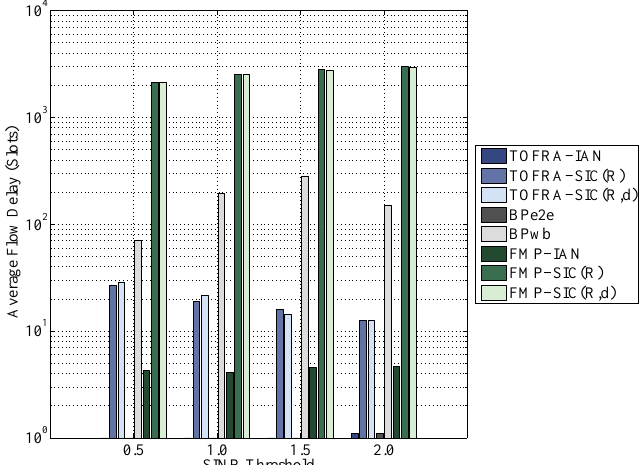
Figure 6. Topology 1: flow delay per flow allocation variant.